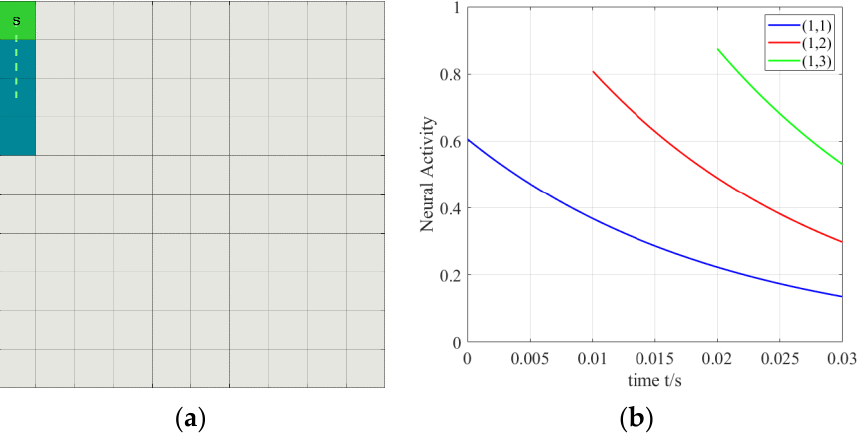
Table 1. Calculation time in different algorithm.